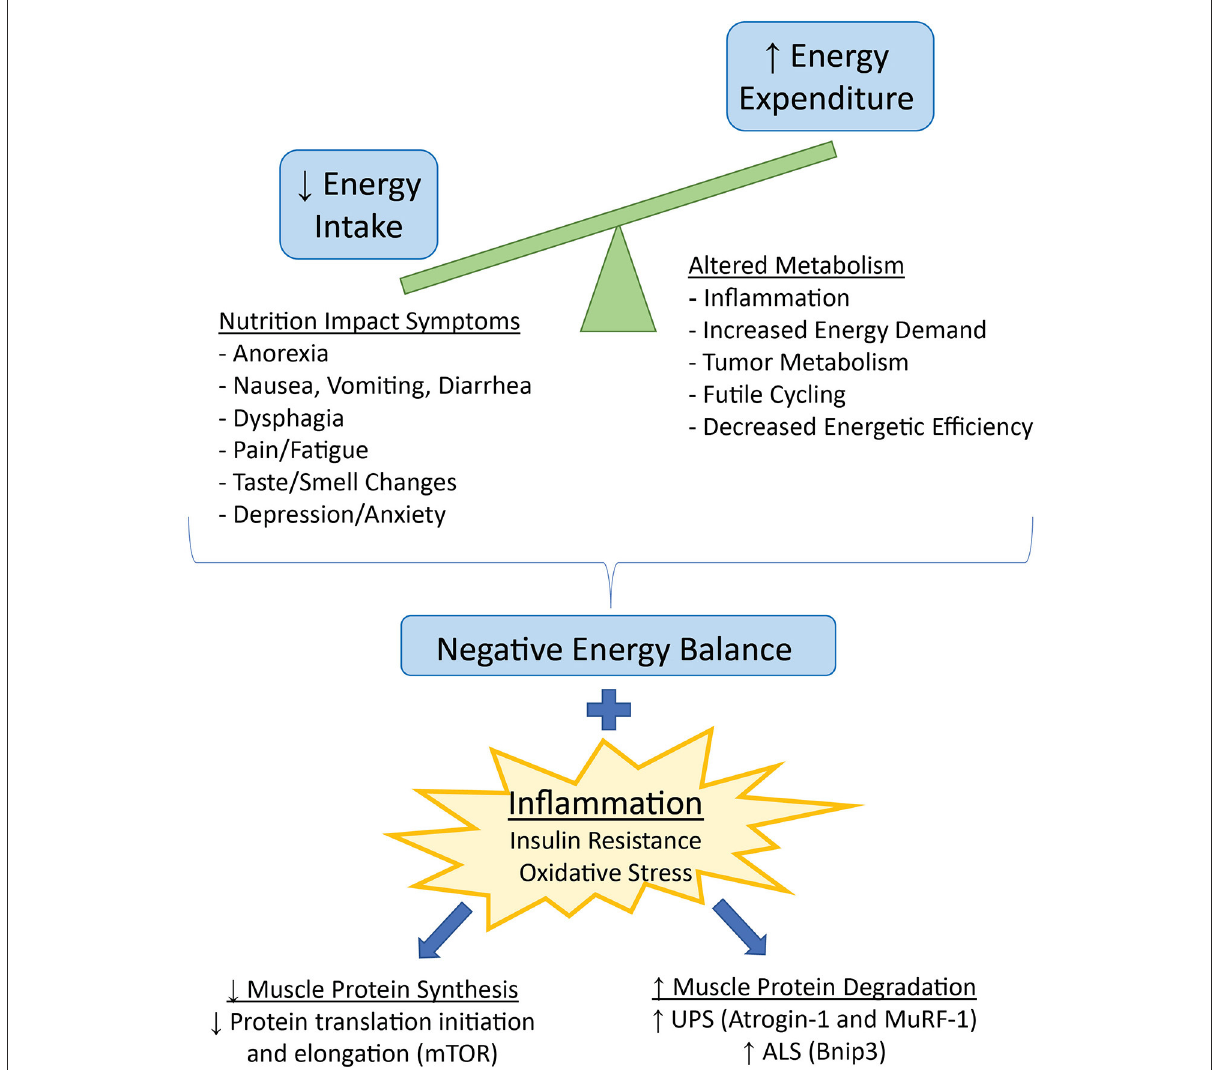
FIGURE1 Factors contributing to decreased energy intake and increased energy expenditure, leading to a net negative energy balance and weight loss in cancer cachexia. Negative energy balance in the presence of inflammation and related insulin resistance and oxidative stress favors loss of skeletal muscle mass via downregulation of protein synthesis and upregulation of protein degradation. UPS, ubiquitin-proteasome system, ALS, autophagy lysosome